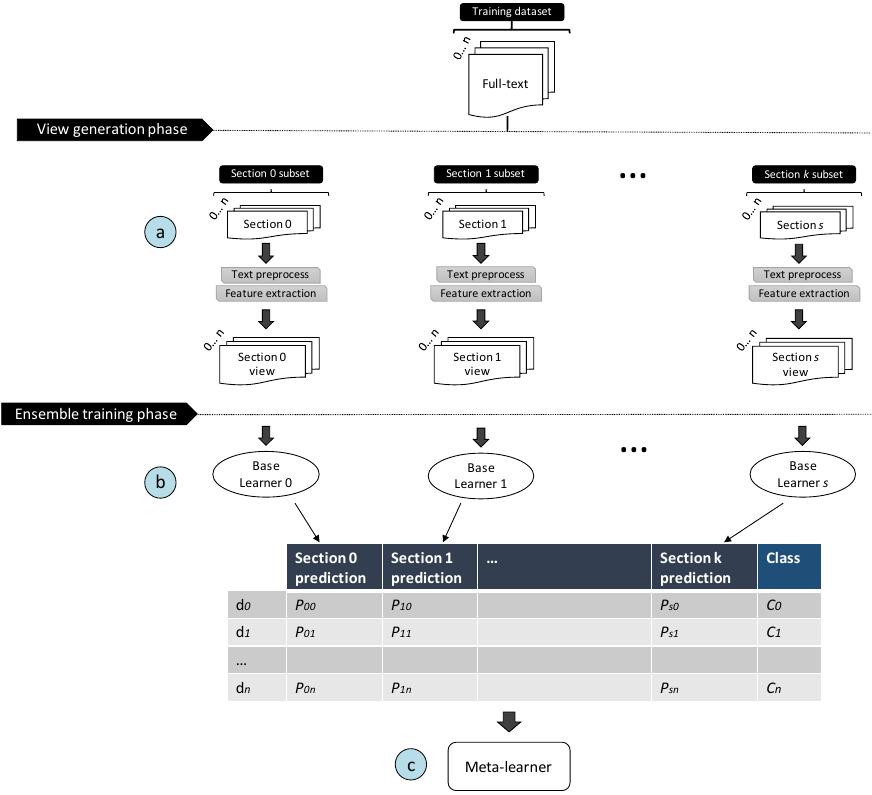
Figure 1. Proposed multi-view ensemble learning architecture: ( a ) view generation phase, ( b ) ensemble training phase, ( c )